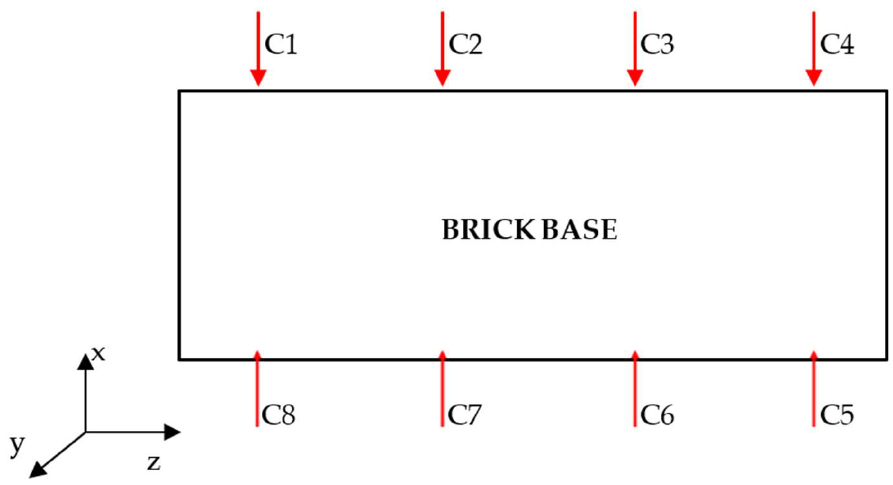
Figure 5. Distribution of measurement points on the research